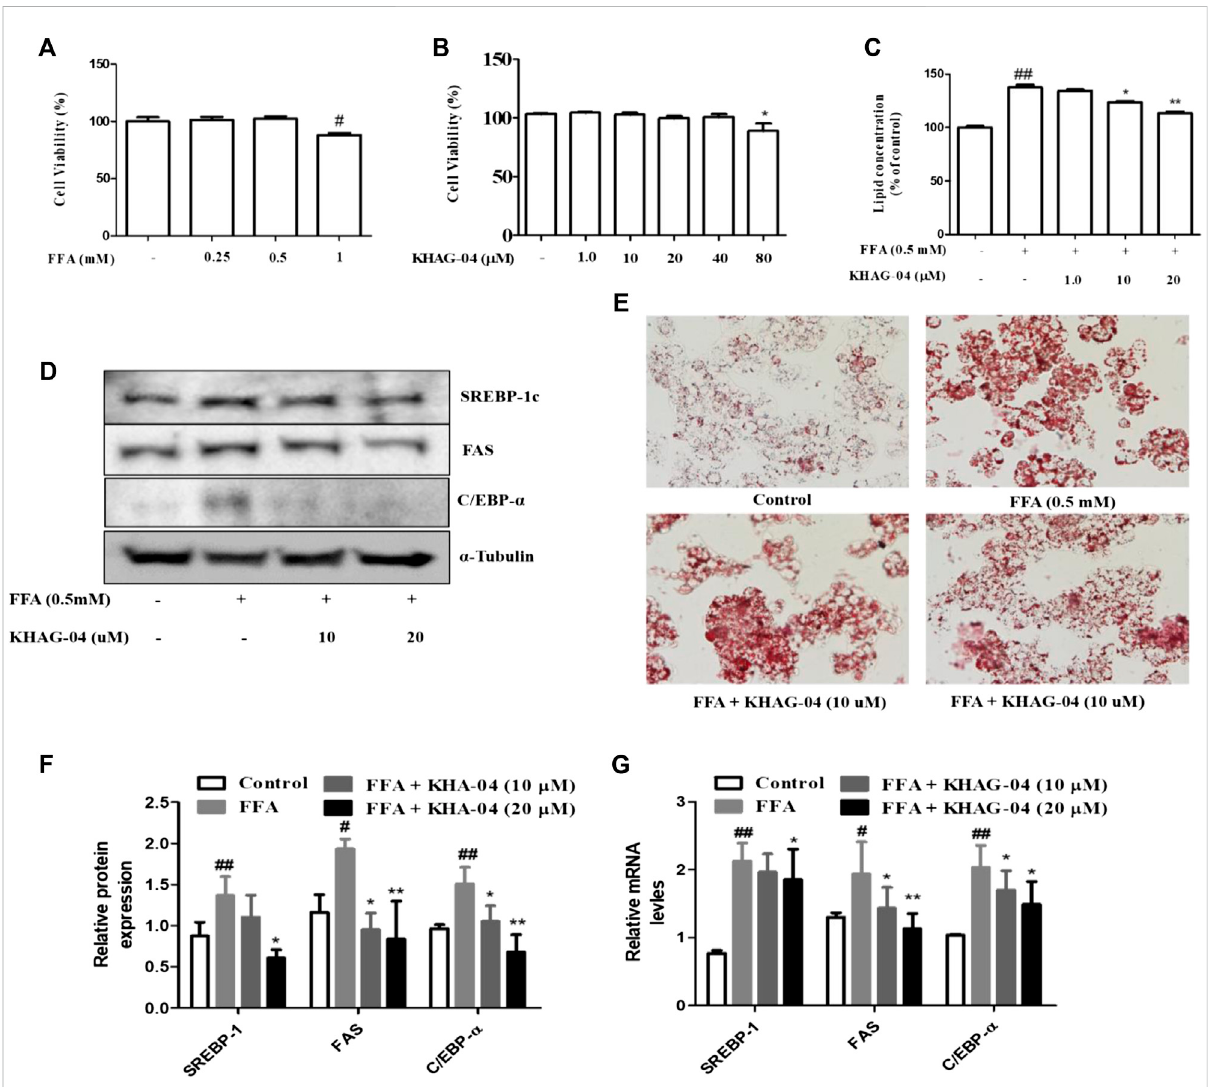
FIGURE 4 Effects of KHAG-04 on FFA-induced lipid metabolism – related markers in HepG2 cells. (A,B) Cell viability of FFA and KHAG-4 in Hep-G2 cells was evaluated using the MTT assay. (C,E) HepG2 cells were pretreated with 10 and 20 μ M of KHAG-04 for 1 h and then stimulated with FFA 0.5 mM for 23 h. FFA-induced lipid droplet accumulation was observed using oil red o staining (×100 magni fi cation). Intracellular lipid concentrations were quanti fi ed by the spectrometer at 540 nm (C) KHAG-04 inhibited FFA-induced protein expression of SREBP-1c, FAS, and C/EBP- α . A Western blot analysis was performed using the indicated antibodies. The mRNA expression of prime metabolic genes (SREBP-1c, FAS, and C/EBP- α ) was detectedafter24 h.Actinwasusedasahousekeepinggene.Alldataareindicatedasmean±SEM( ## p < 0.001vsControl;** p < 0.001vs0.5